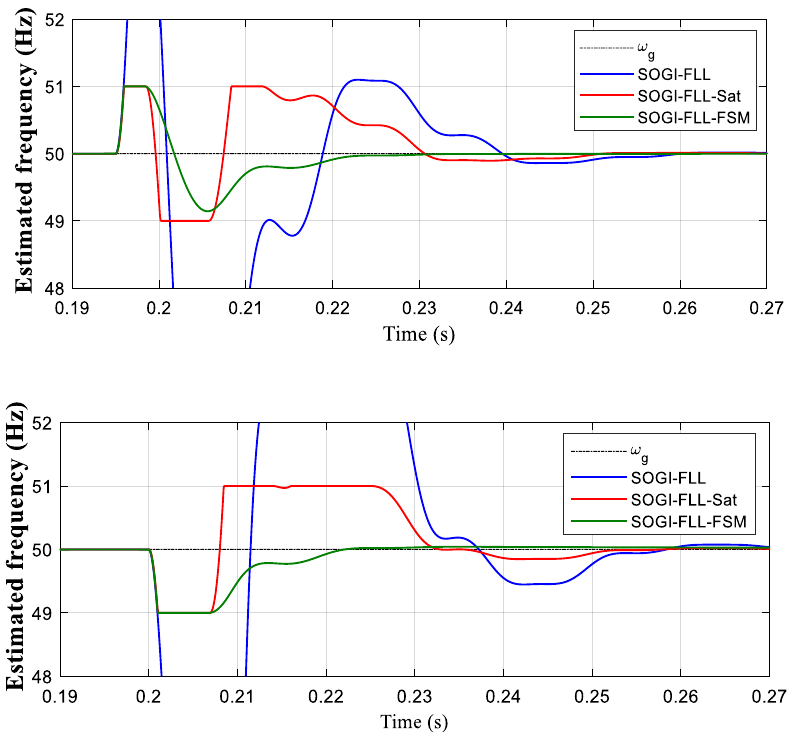
Figure 10. Transient responses to a 70% sag depth using the equations of Tables 2 and 3 to obtain ξ and λ . In blue: SOGI-FLL. In red: SOGI-FLL with saturation. In green: FSM-based SOGI-FLL Upper: type-a sag. Lower: type-b sag.